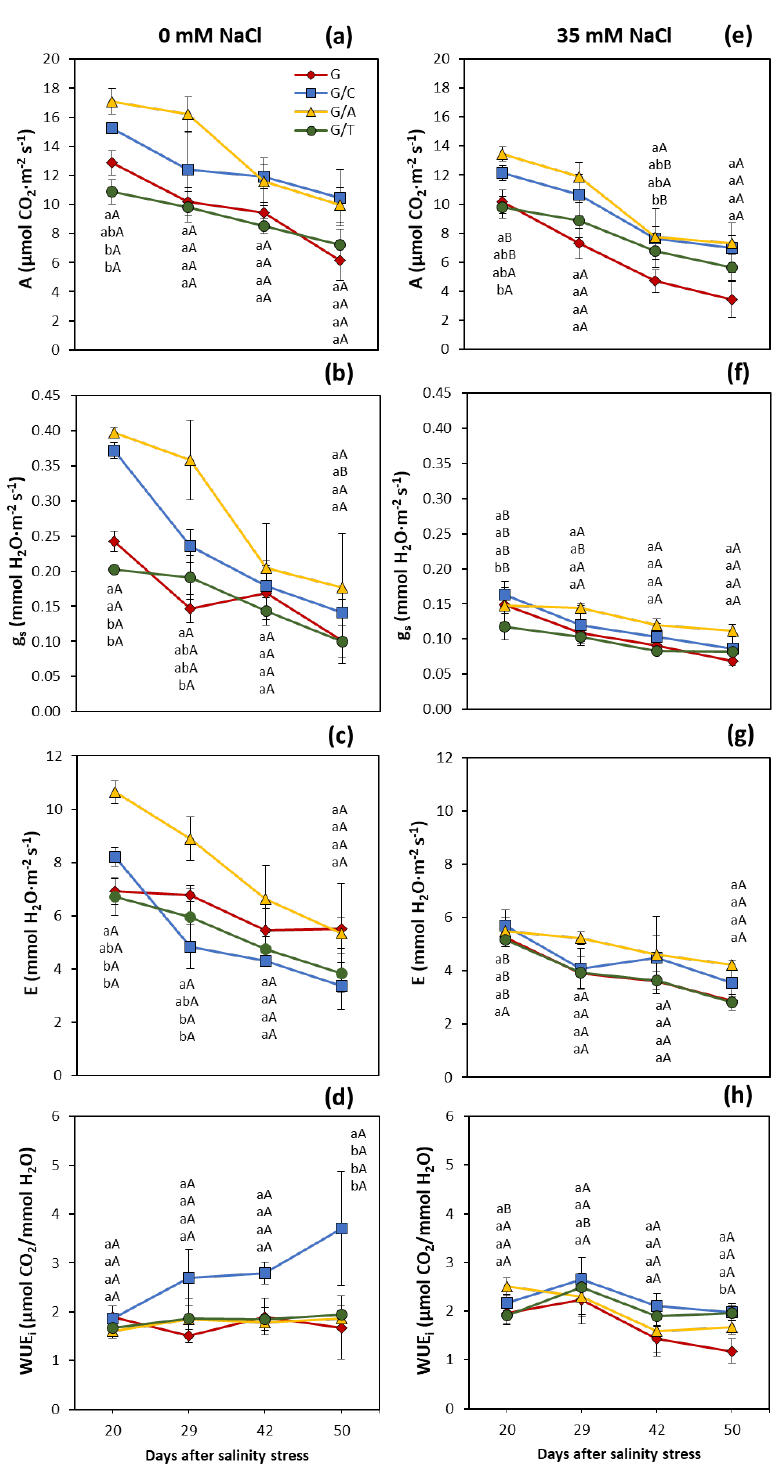
Figure 2. Evolution of ( a , e ) photosynthetic rate ( A ), ( b , f ) transpiration rate ( E ), ( c , g ) stomatal conductance ( g s ), and ( d , h ) intrinsic water use efficiency (WUE i ) in leaves of pepper plants of the commercial variety “Gacela F1” either non-grafted (G) or grafted onto the commercial rootstocks, Creonte (G/C), Atlante (G/A), and Terrano (T/A), and cultivated under control (0 mM NaCl) and salinity (35 mM NaCl) conditions. Line points show the means of five plants ± standard error. Different capital letters indicate significant differences due to the salt treatment while different small letters show significant differences among graft combinations for each time-point according to Tukey’s test ( p ≤ 0.05).